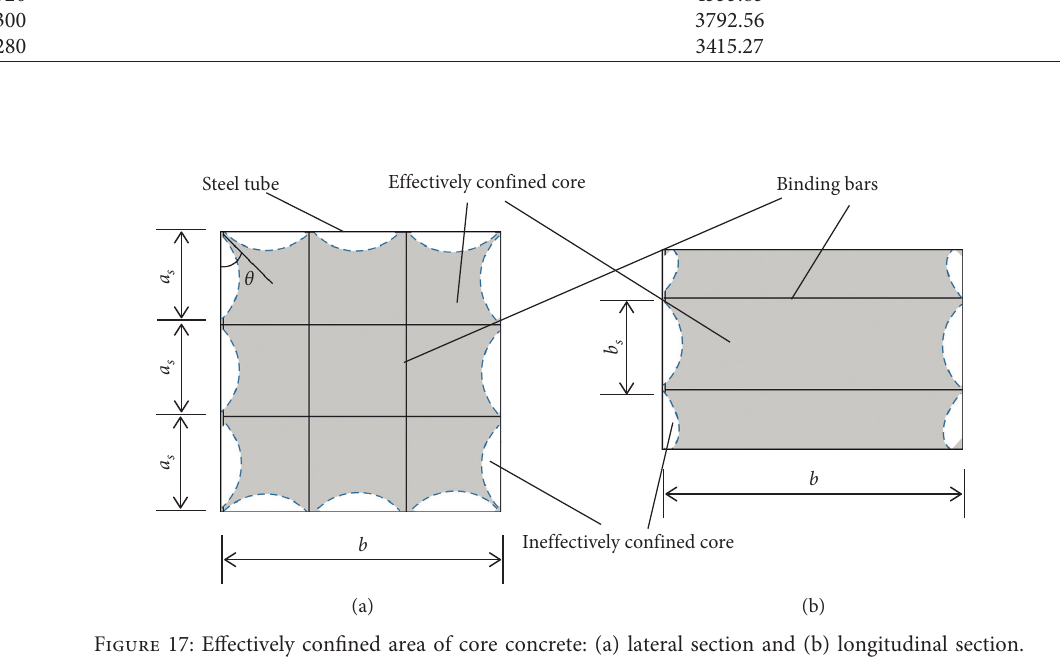
Table 6: Influence of section dimension on ultimate axial bearing capacity and displacement of the specimen. Section dimension of the column (mm × mm)